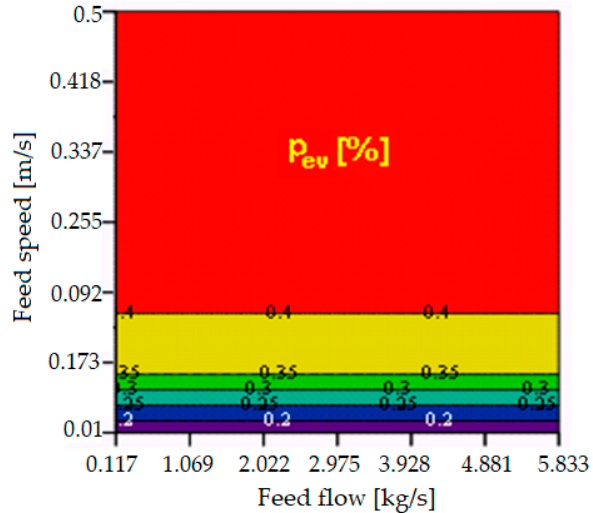
Figure 15. Graphic representation of evacuation losses ( p ev ) as a function of feed speed ( v a ) and feed flow ( Q ).